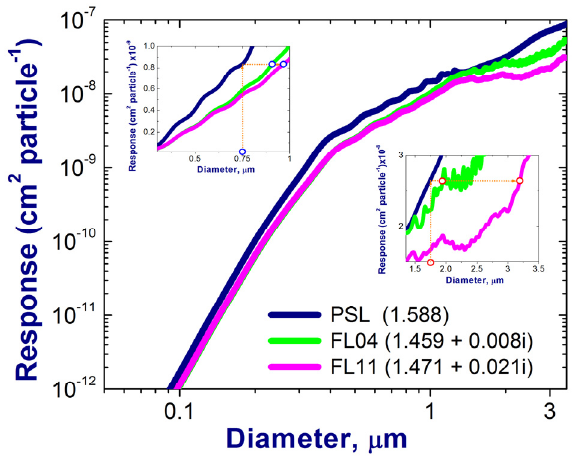
Figure C1. Example of theoretical response curves as a function of dry diameter (D dry ) calculated for spherical particles and different values of complex RI. These values represent polystyrene latex spheres (PSL; navy blue) and those calculated for two FLs